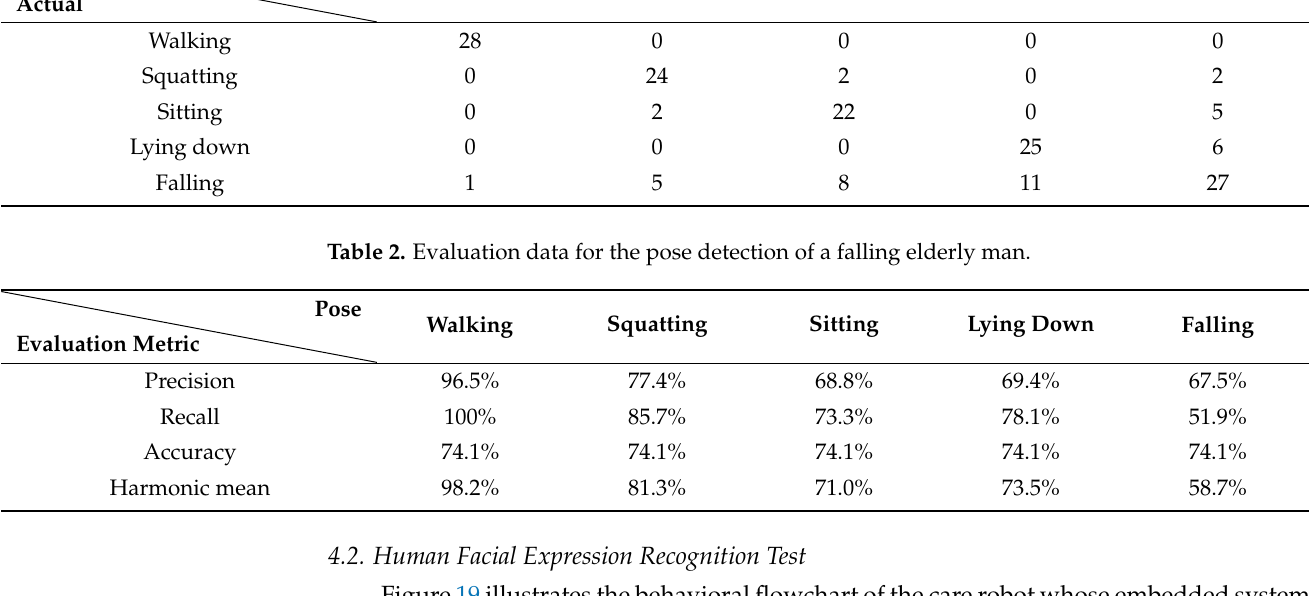
Table 1. Confusion matrix for the pose detection of a falling elderly man. Prediction